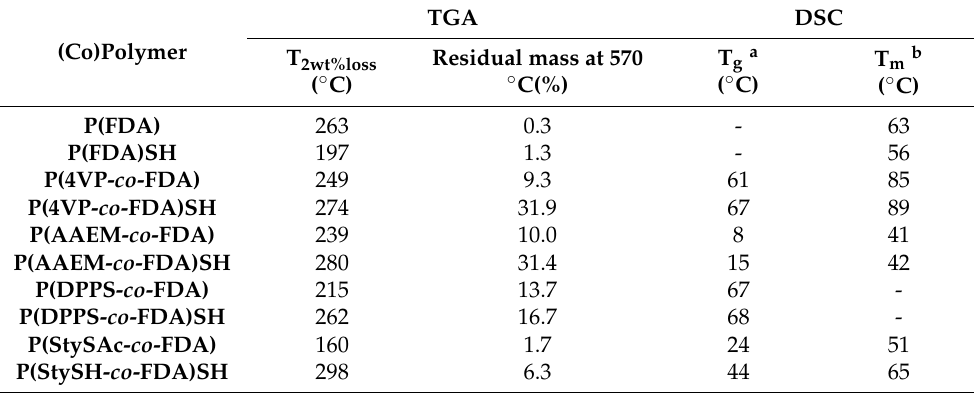
Table 3. Thermal properties of the synthesized